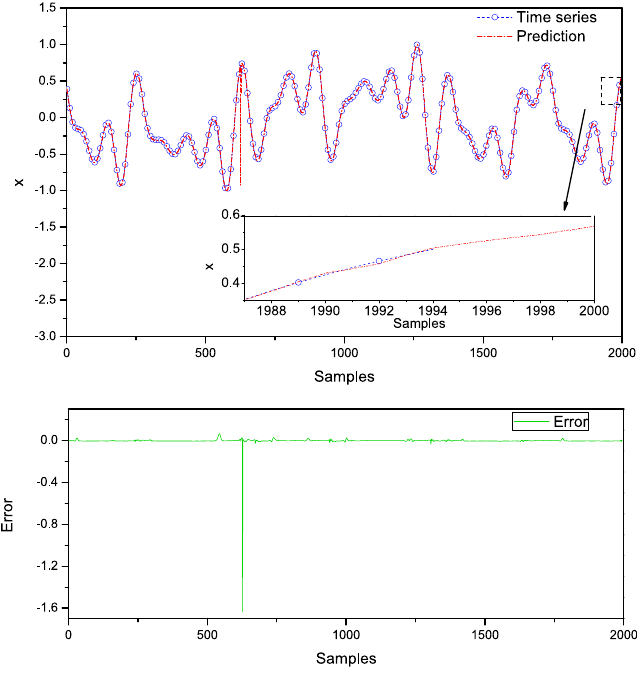
Figure 11. Six steps ahead prediction result of the five-layer MLP for the chaotic time series with MLE =